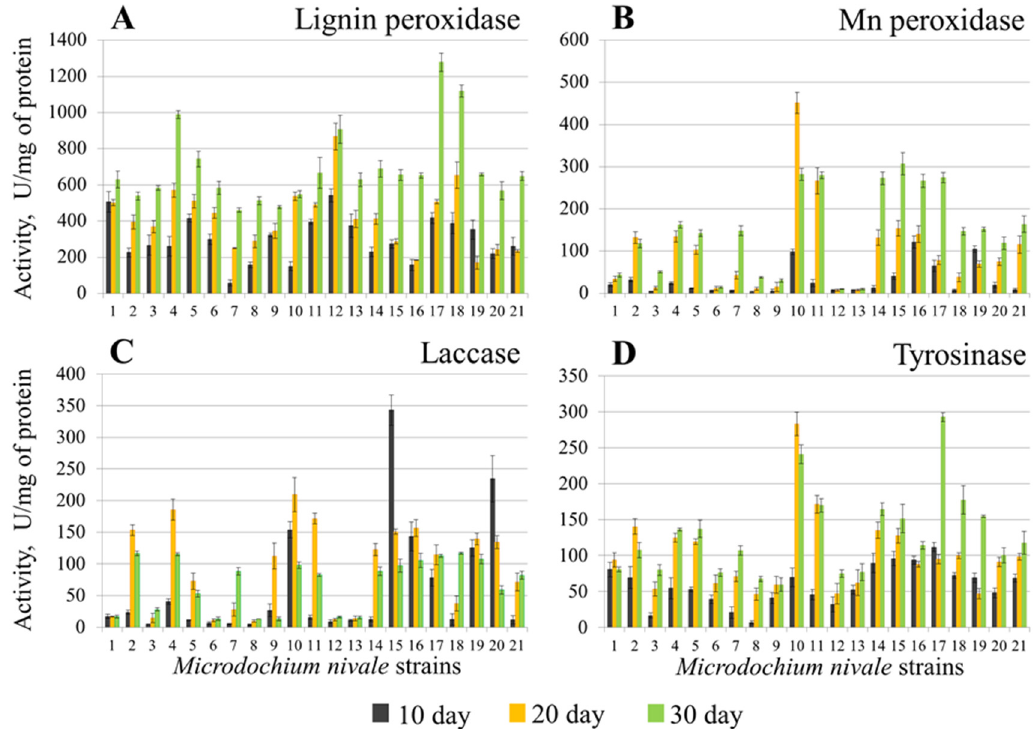
Figure 1. Extracellular lignin peroxidase ( A ), Mn peroxidase ( B ), laccase ( C ), and tyrosinase ( D ) activities of the Microdochium nivale strains grown in potato sucrose broth medium. Black columns —10 days of cultivation, orange columns—20 days of cultivation, green columns—30 days of cultivation. The presented values are averages ± SD of three biological replicates.